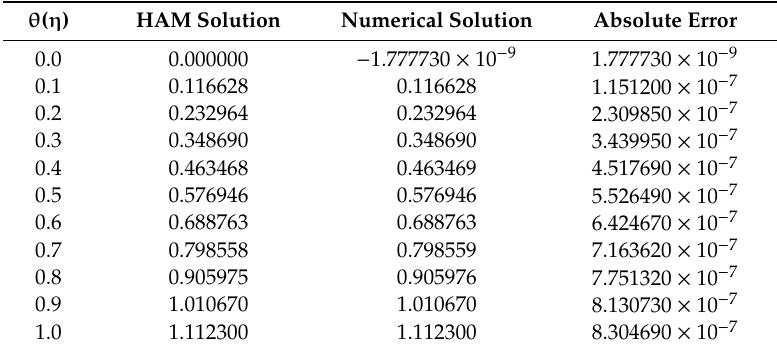
Table 5. Comparison of HAM and numerical solution for θ ( η ).